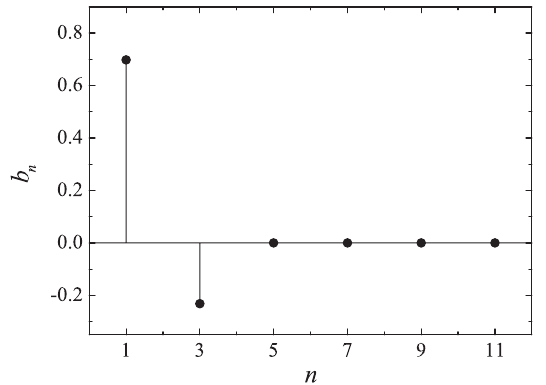
FIG. 3. The normal multipole coefficient b n of an elliptic beam ð (cid:4) Þ þ tube shown in Fig. 1. The sextupole component has maximum 1 ð (cid:4) Þ (cid:2) a ð (cid:4) Þ . value in higher orders of n (cid:6) 3 2 1